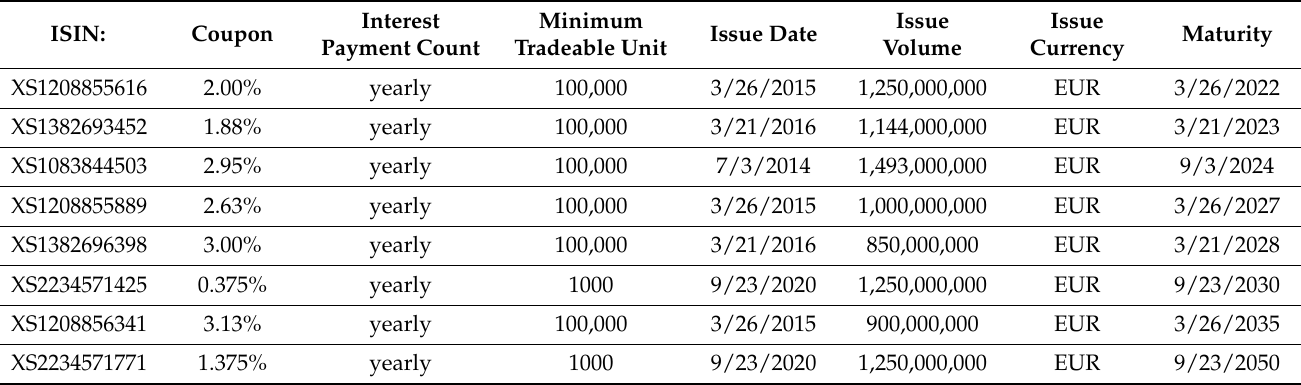
Table 13. Bulgarian’s Sovereign Bonds parameters.